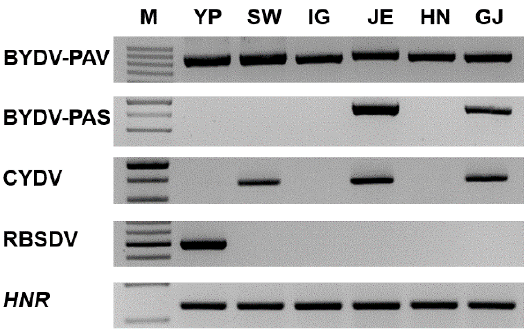
Figure 8. Confirmation of the identified viruses infecting oats by RT-PCR. RT-PCR results with specific primers; BYDV-PAV, BYDV-PAS, CYDV, and RBSDV. The HNR was used as an internal control [39]. Amplified PCR products were visualized by 1.2% agarose gel electrophoresis. The total RNA extracted for RNA-seq were used for RT-PCR.